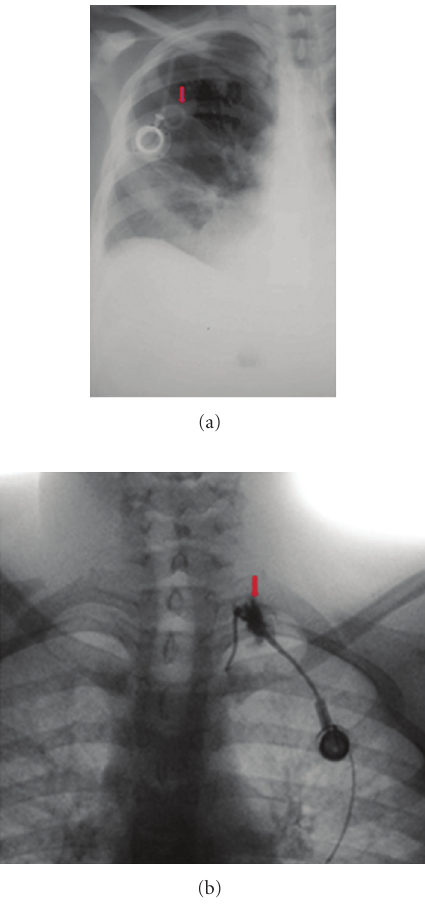
Figure 6: Two patients with surgically installed subcutaneous ports anterior thorax before chemotherapy starts. The line will allow treatments to be given and blood samples obtained without being “stuck” with a needle. At the end of the treatment, the central line is removed. (a) It shows a looped catheter and (b) shows dissection of the vessel.